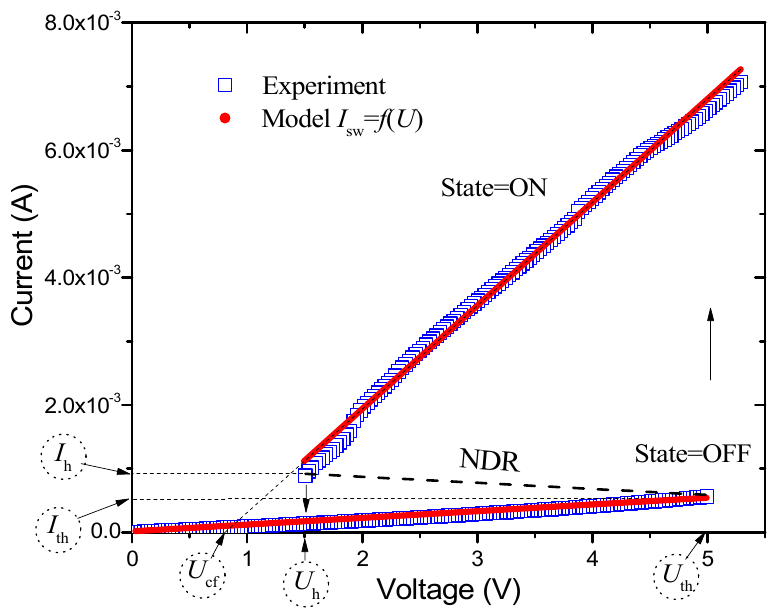
Figure A1. Circuit of a single oscillator of a VO 2 -based structure. I is the number of an oscillator; I p_i is a source of current, C is a capacitance, U n_i is a source of noise, I sw_i is the current through the VO 2 switch, U i is the voltage at the switch.